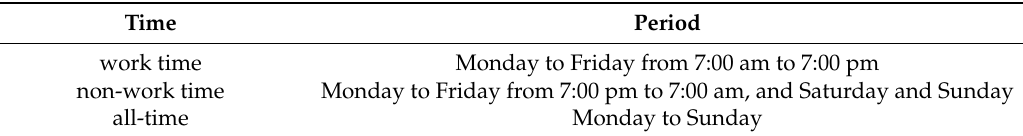
Table 2. Period details.